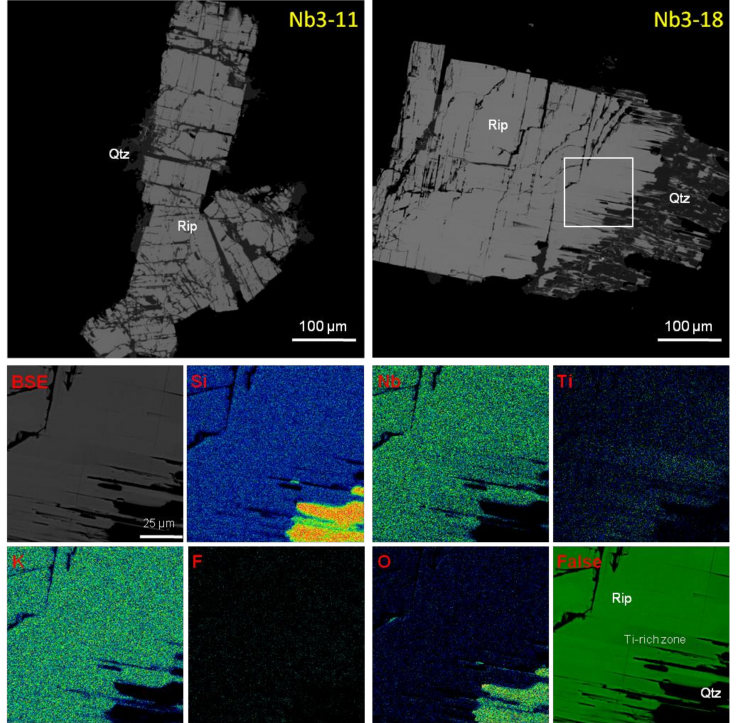
Figure 5. Rippite crystals partially resorbed by quartz (BSE images) and elemental maps for area with Ti-rich composition (holotype sample 546-193.5). Rip—rippite;